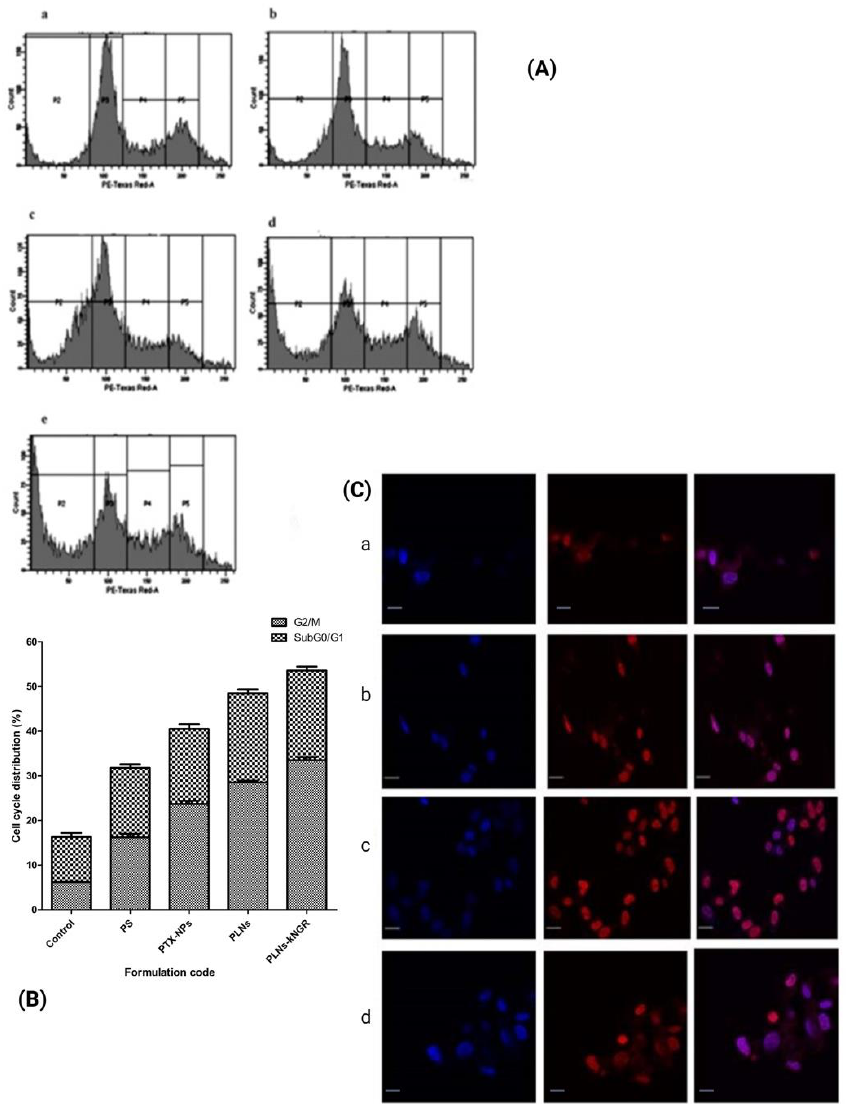
Figure 6. ( A ) Representative photomicrographs of cell cycle distribution in HT-1080 cells. Cells were incubated in the presence of various PTX-loaded formulations at equivalent drug concentration of 0.5 µg/mL for 36 h and analyzed by flow cytometry. Areas P2, P3, P4 and P5, represent sub-G0/G1, G0/G1, S and G2/M phases, respectively, of the cell cycle. ( A ) ( a ) Control ( b ) PS ( c ) PTX-NPs ( d ) PLNs ( e ) PLNs-KNGR. ( B ) Kinetics of distribution of the G2/M and sub-Gs0/G1 population induced by PTX-based formulations. ( C ) Cellular association of various formulations in HT-1080 cells ( a – d ) as showed CLSM using FITC as the fluorescence probe. ( a ) PTX-NPs ( b ) PLNs ( c ) Targeted kNGR-PLN-NPs in HT-1080 ( d ) kNGR-PLNs in the presence of excess kNGR in HT-1080 cells. Microscopic images were taken as 20X